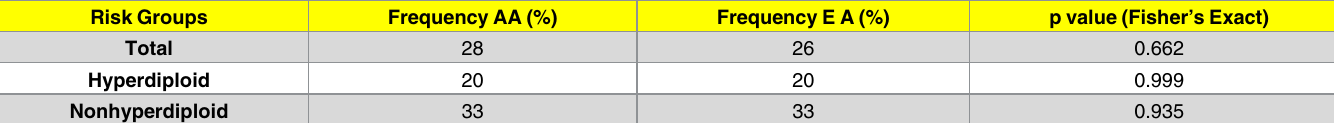
Table 2. Frequency analysis of Arkansas 70 high-risk genes expression